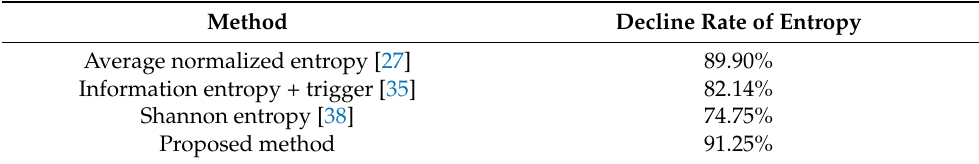
Table 5. Comparison with other attack detection